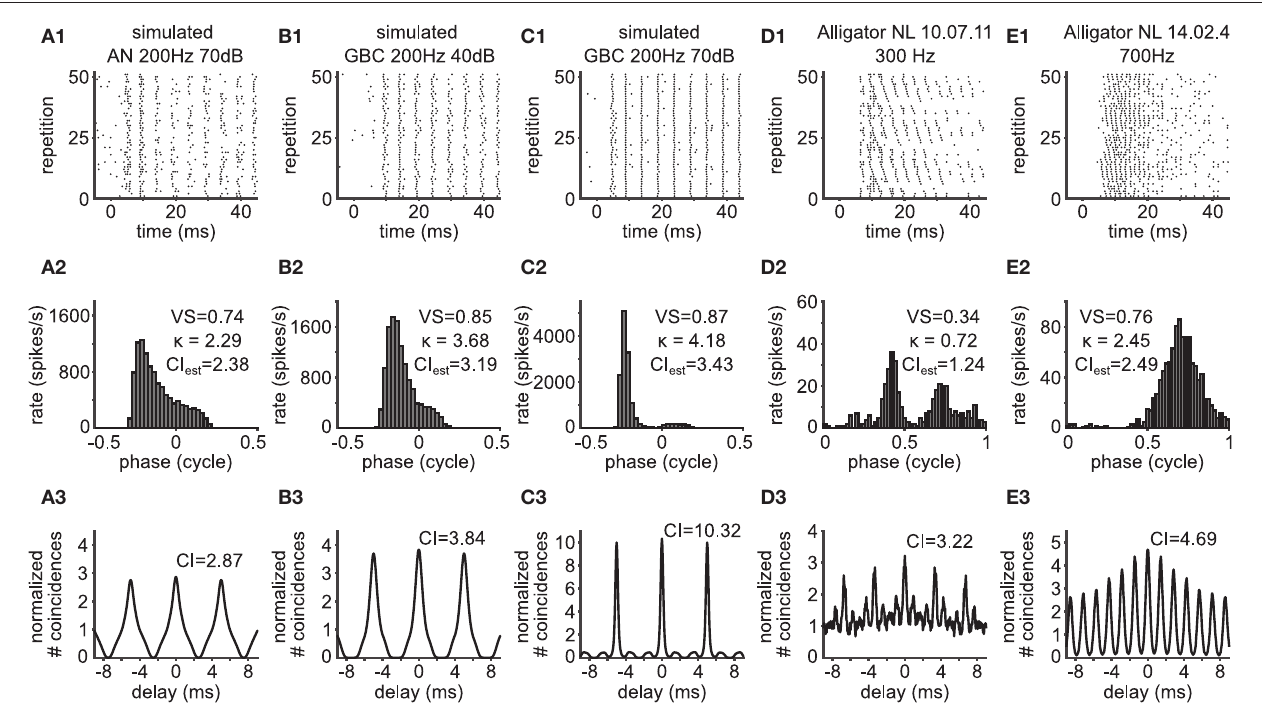
FIGURE 4 | Violation of the theoretical assumptions for the VS-CI relationship. Each column shows the response of a unit whose CI value deviates from the theoretical value estimated from its VS. Corresponding data points are indicated by arrows in Figures 3B,C . (A1–E1) Raster plots. The sound stimulus starts at time zero. (A2–E2) Phase histograms with VS values, from which the value of κ was back-calculated and then the value of CI was estimated. (A3–E3) SACs with CI values. Note the difference between the estimated CI in (A2–E2) and actual CI in (A3–E3) . To the alligator NL units, pure tone stimuli were presented binaurally with an interaural time difference ranging from –2,000 to +2,000 µ s in a step of 250 µ s, repeated three times (D1–D3) ; or from –1,000 to +1,000 µ s in a step of 100 µ s, repeated 5 times (E1–E3) ; only 51 repetitions are shown in (E1) , but all repetitions are used for (E2,E3)